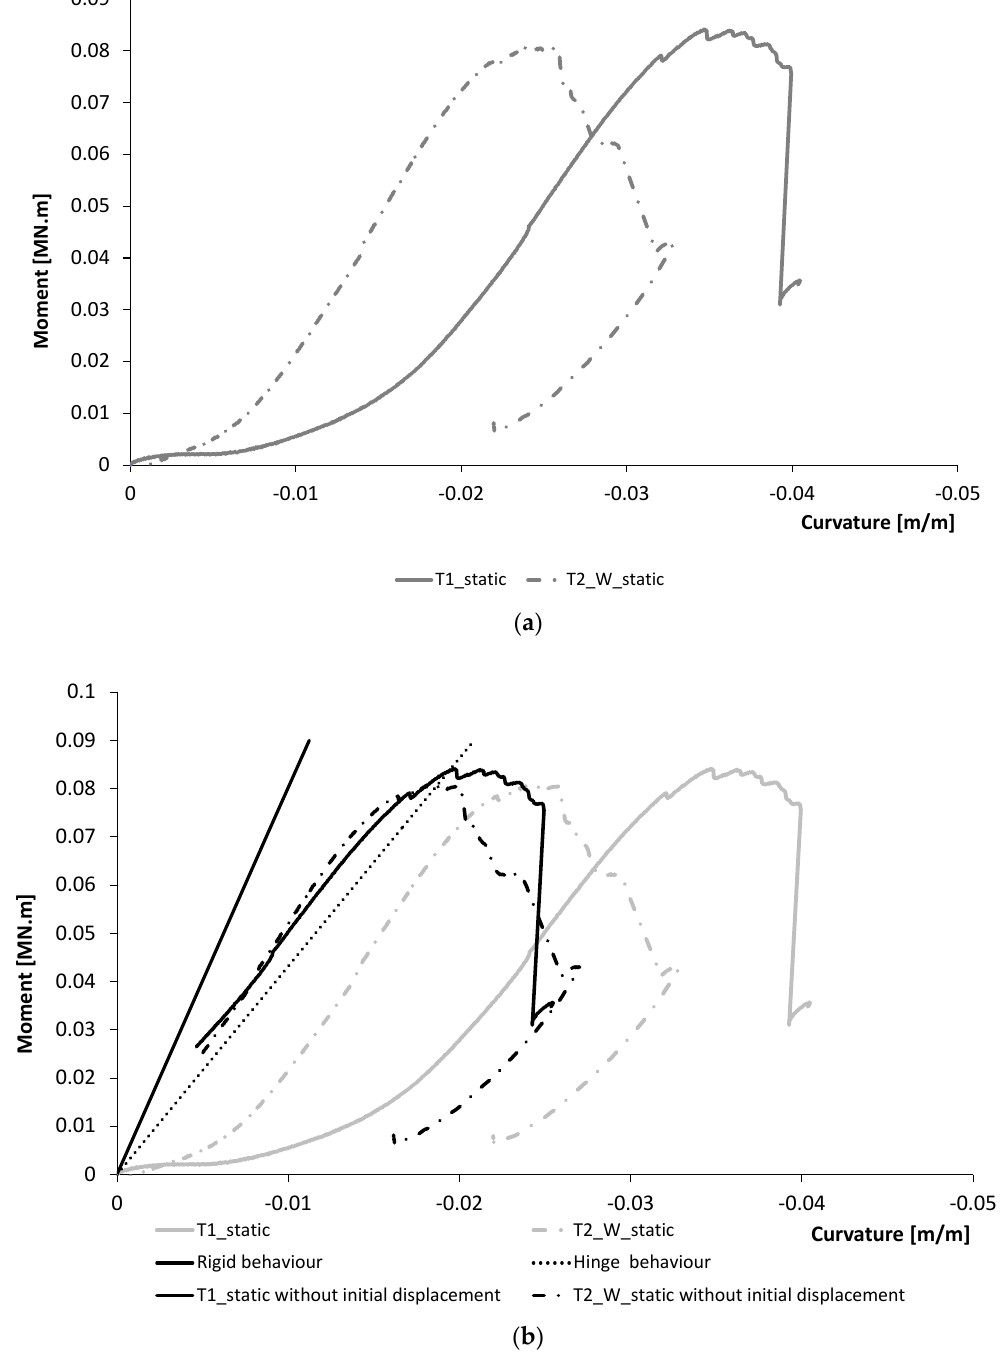
Figure 13. Moment–rotation response of T1 and T2_W specimens tested in static loading conditions. ( a ) Experimental results with sliding. ( b ) Experimental results without initial sliding and comparison with calculations.